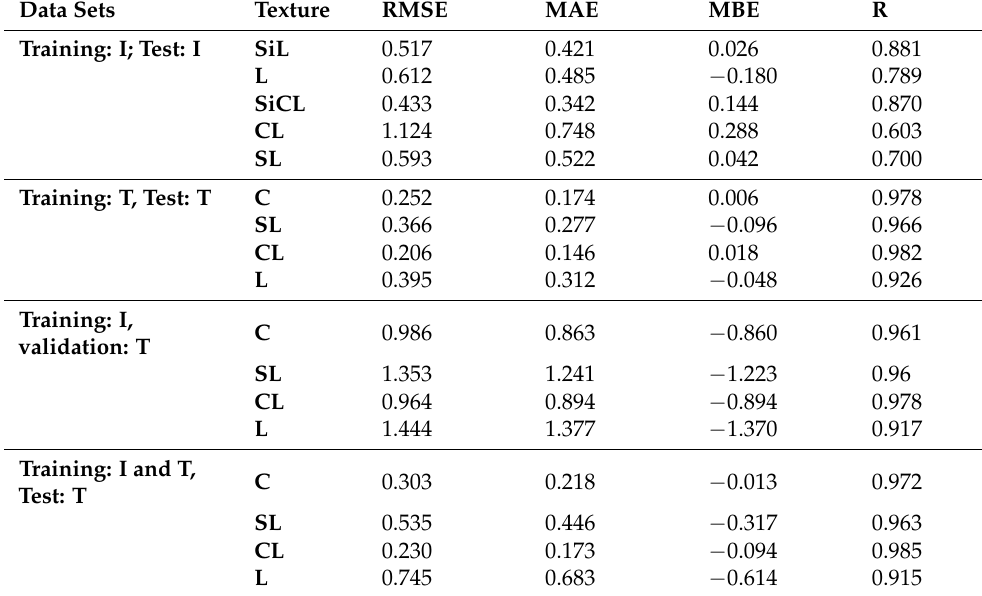
Table 5. Performance of PC-PTFs on main textural classes of the international and Turkish data sets for estimating